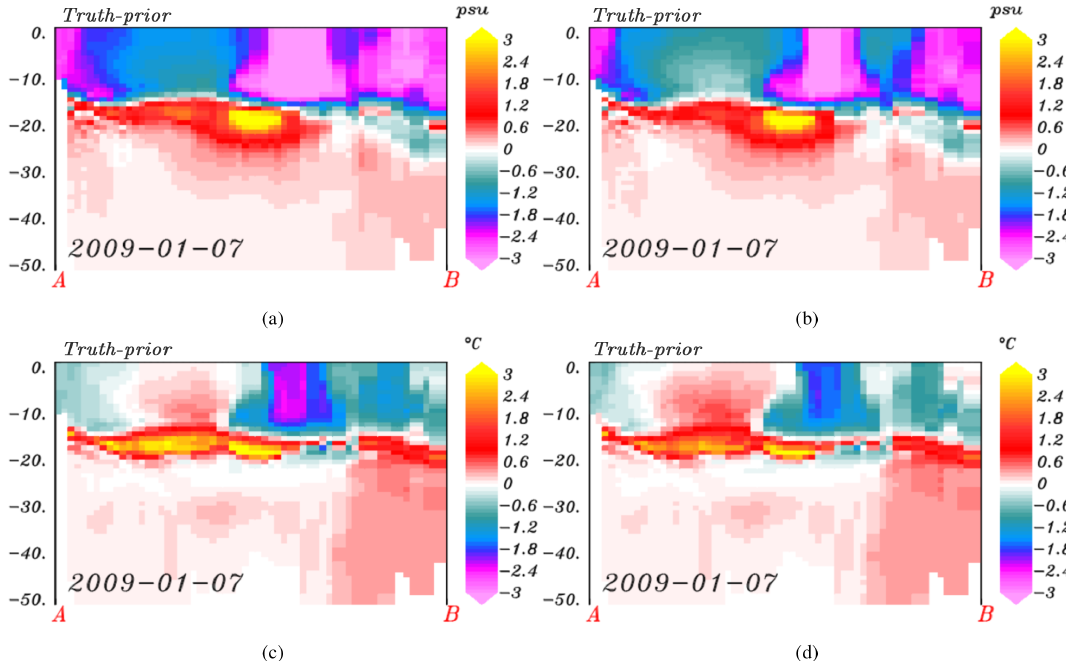
Figure 10. Vertical distribution of salinity (a, b) and temperature (c, d) difference between the NR and the prior ensemble mean along the cross section A–B (see Fig. 5) on 7 January 2009 for FB001 (a, c) and FB002 (b, d)